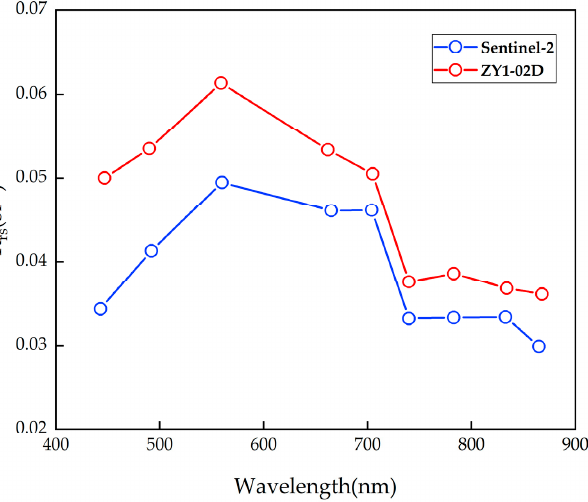
Figure 15. Average remote sensing reflectance of Sentinel-2 and ZY1-02D images at Dataset 2 sites. 364